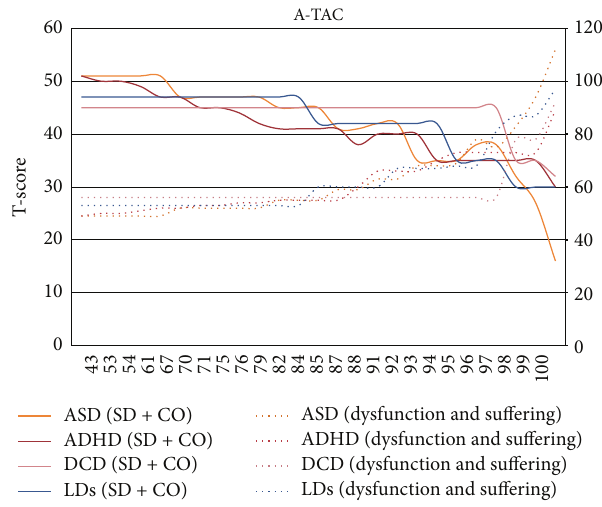
Figure 2: The graph shows means in SD + CO and dysfunction and suffering (T-scores) as a function of the population percentile. SD + CO: left-axis scale; dysfunction and suffering: right-axis